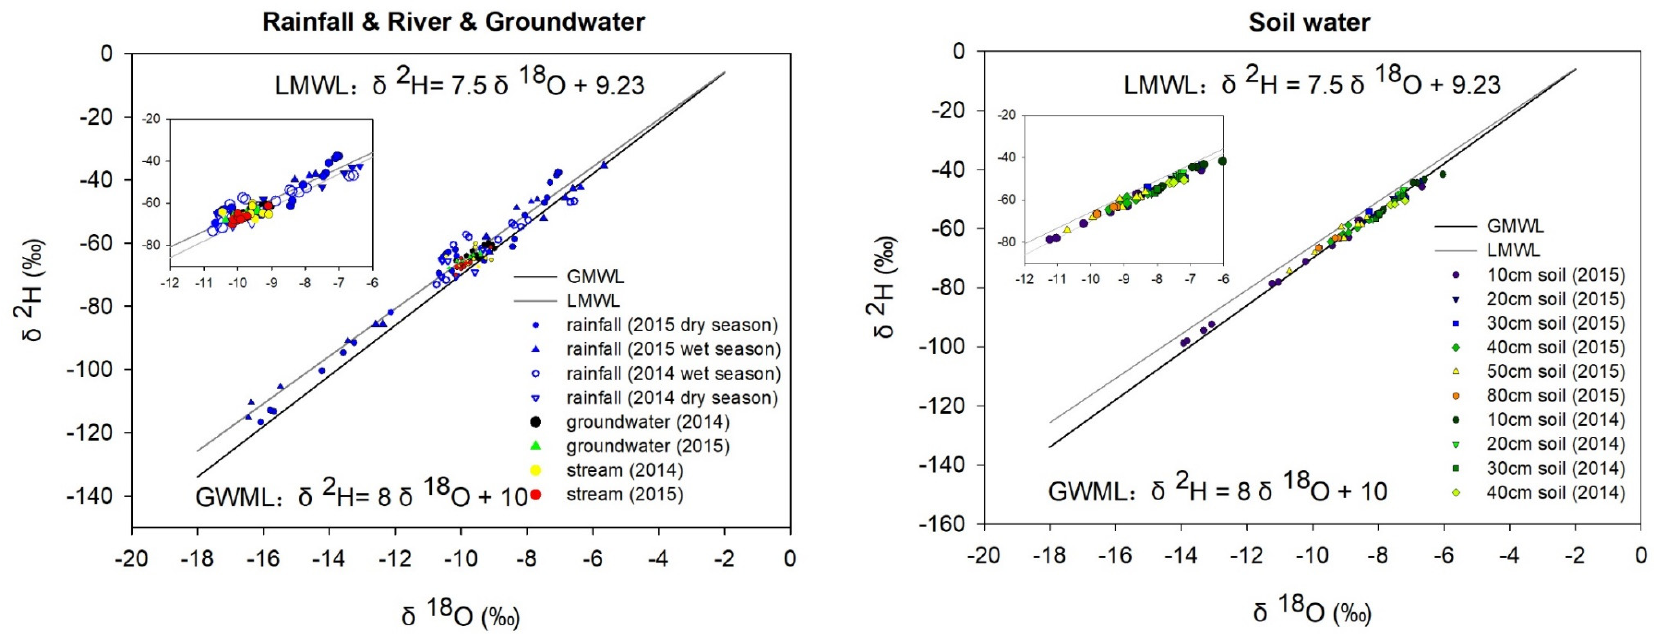
Figure 5. Isotope signatures of rainfall water, (sampled biweekly at Hillslope1 and Weather Station 1 (Figure 1)), stream water sampled at weir, groundwater sampled at well 1-3 and 3-2, and soil water sampled on Hillslope1 at six depths (10, 20, 30, 40, 50, 80 cm). All the samples except soil water were taken biweekly (wet season, May to September) and monthly (dry season, October to April) throughout the study period. Soil water samples were collected in 6 storm events.